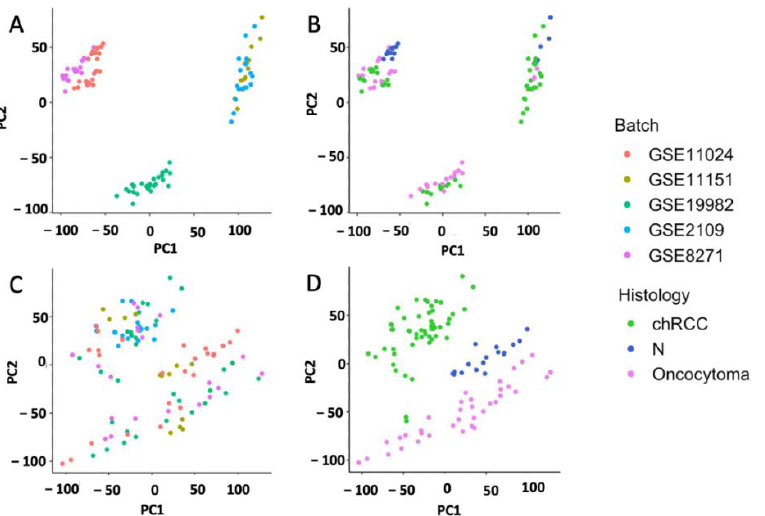
Figure 2. Quality control of the discovery dataset showing batch effects before and after correction. Principal component analysis showing differences in batch ( A ) is higher than difference in histology ( B ) for chromophobe (chRCC) and renal oncocytoma (RO) and normal kidney tissue arrays (N) before batch effect correction. After batch correction by empirical bayes (ComBat), histological differences ( D ) are higher than batch differences ( C ).